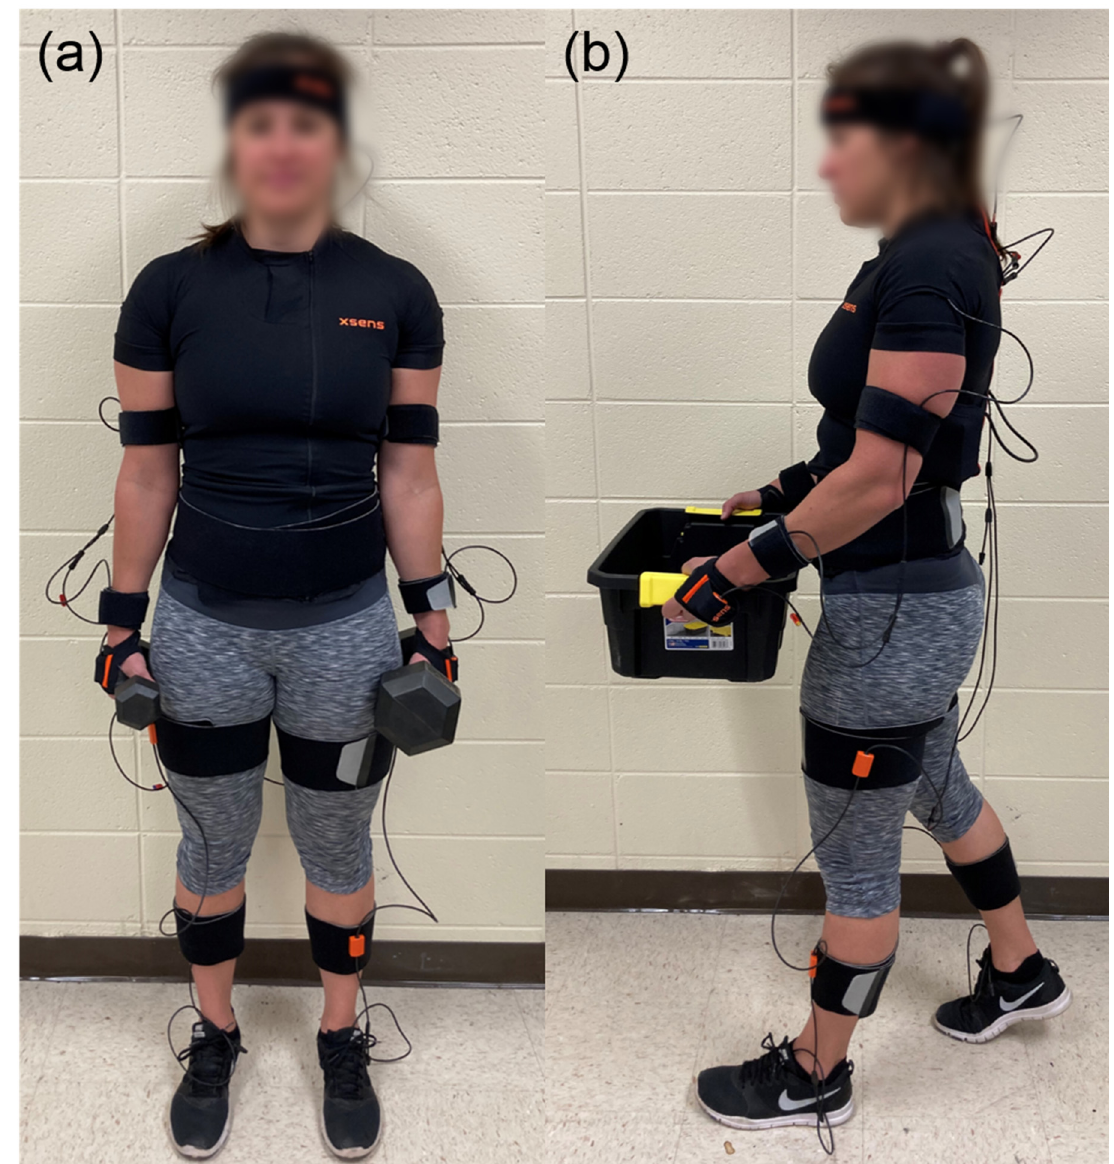
Figure 1. A participant carrying asymmetric dumbbells ( a ) or a box ( b ) while wearing the full-body inertial measurement system (Xsens) and wireless electromyography electrodes on the low back (not visible, obscured by clothes).